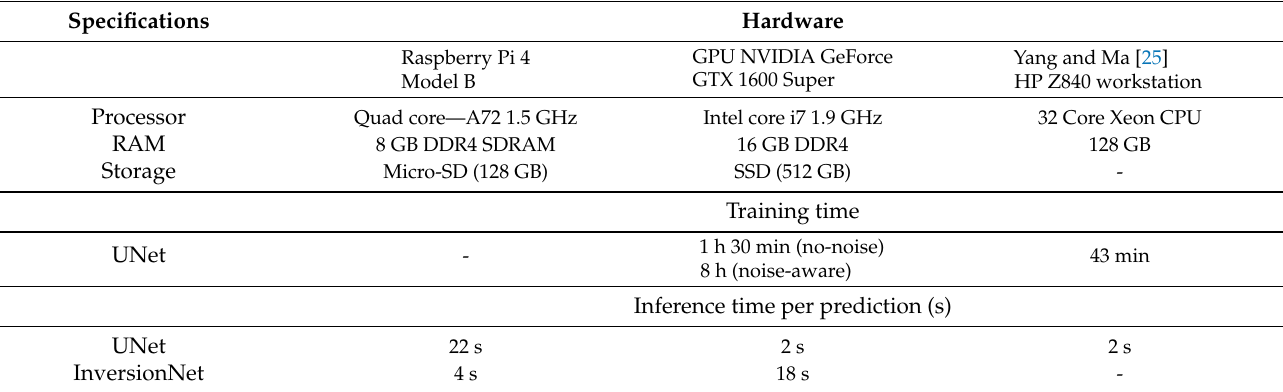
Table 3. Comparison of training and inference times on Raspberry Pi, GPU PC and Yang and Ma